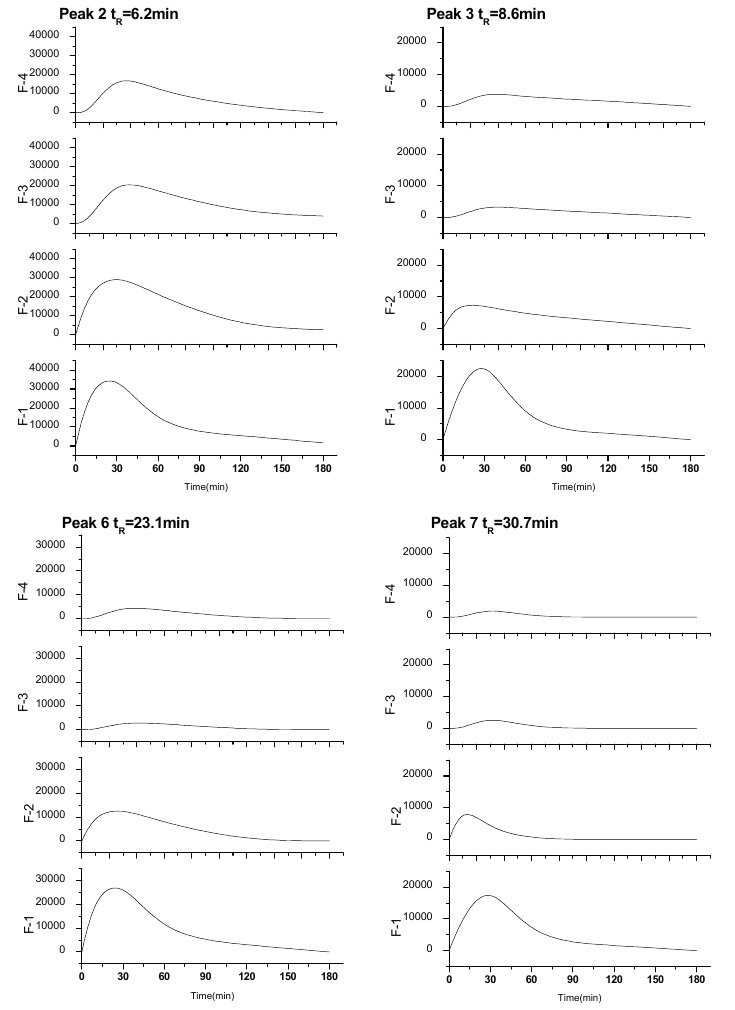
Figure 6. The time-dependent peak area curve of four kinds of constituents absorbed into blood after four different concentration of Fenge water decoction oral administration, ingredients of peaks 6 and 7 were original compositions, while peaks 2 and 3 were